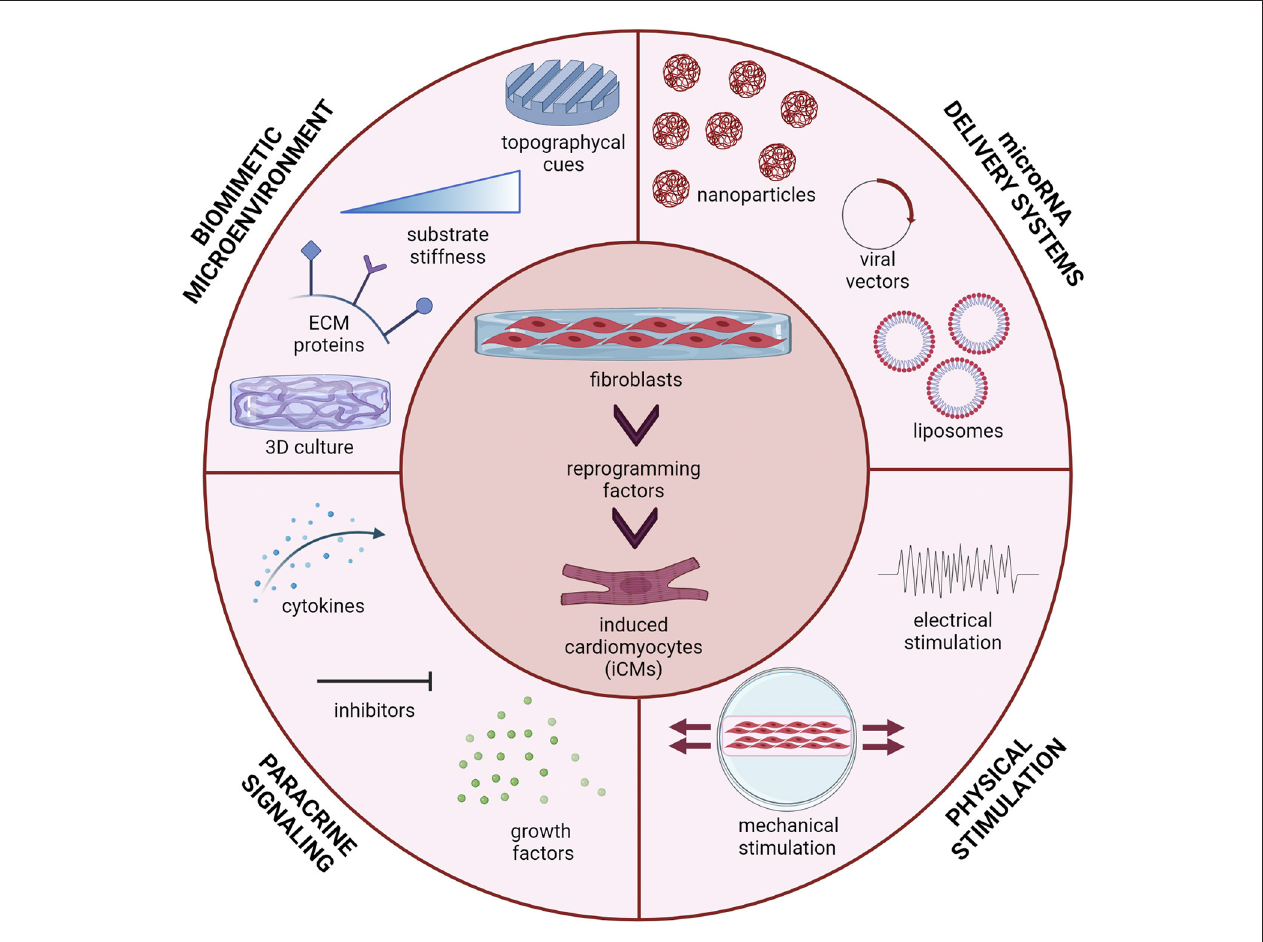
FIGURE 1 | Multiple stimuli can affect direct reprogramming (DR) of fibroblasts into induced cardiomyocytes (iCMs): microRNA delivery strategy (viral vectors, liposomes, polymeric nanoparticles); the microenvironment in which cells are cultured (three-dimensional culture, topographical cues, substrate stiffness and extracellular matrix proteins); paracrine signals (cytokines, inhibitors and growth factors) and physical stimuli (mechanical stretching, electrical stimulation). Figure was created using